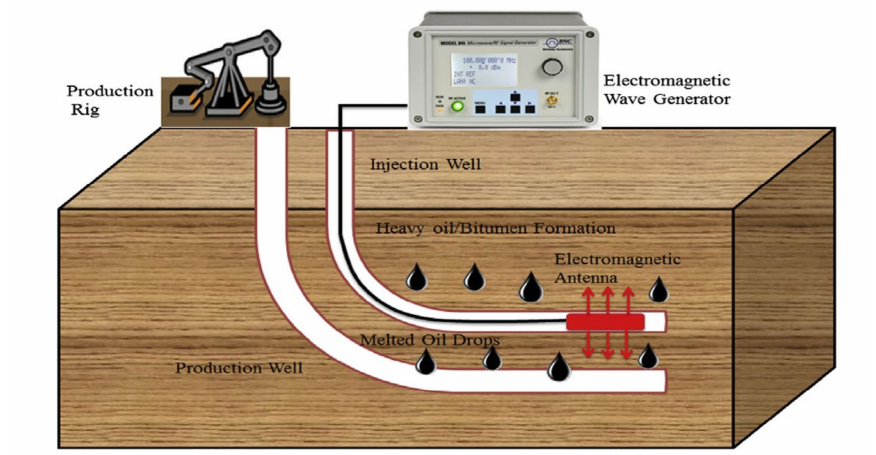
Figure 6. EM heating for Enhanced Oil Recovery (EOR). Source: Bera A. et al. [75] reprinted with